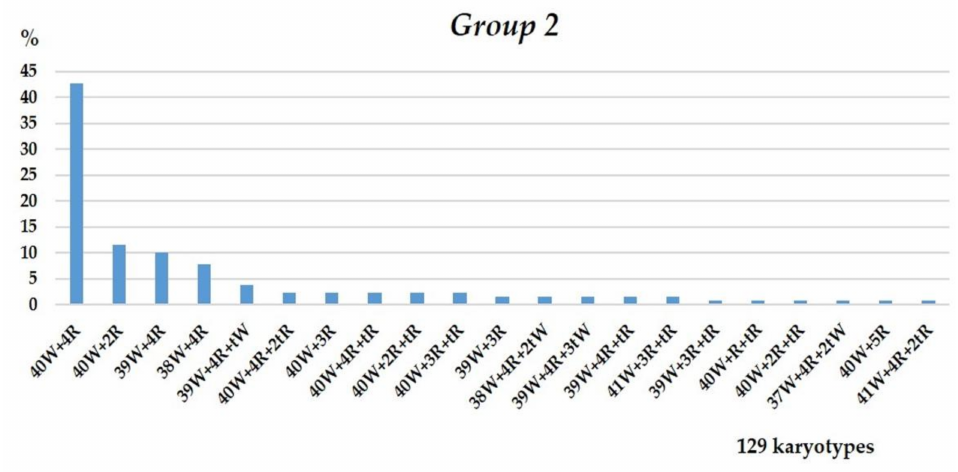
Figure 9. Frequencies of different chromosome sets in plant karyotypes of Group 2. Designations follow Figure 4.